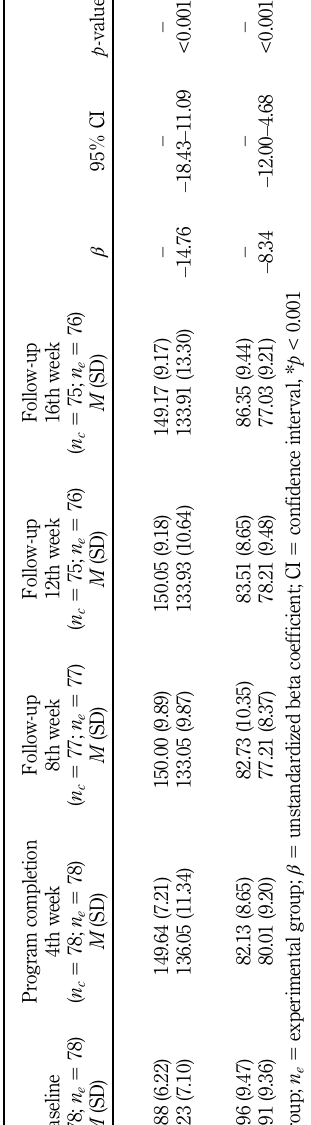
Table 3. Comparison of blood pressure over time between the two groups by using generalized estimating